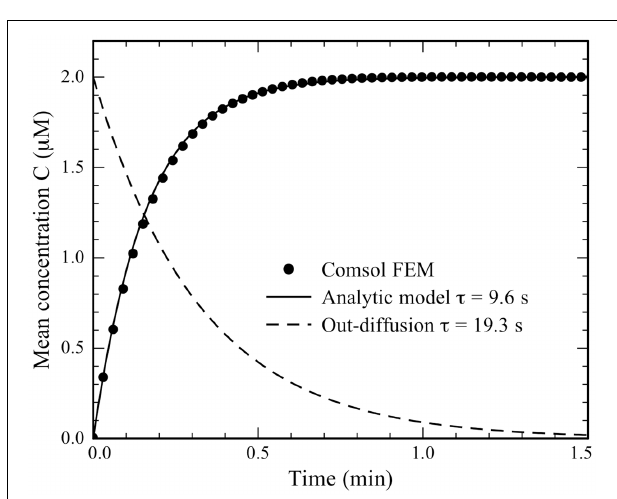
FIGURE 3 | The average concentration of MBs in the cell as a function of transfection time. Results from a COMSOL FEM model (dots) are compared to the analytical model (black line) with the time constant τ c = 9 . 6s. The average concentration in the outdiffusion experiment calculated from the analytic model is shown as the dashed curve using the time constant τ o = 19 .